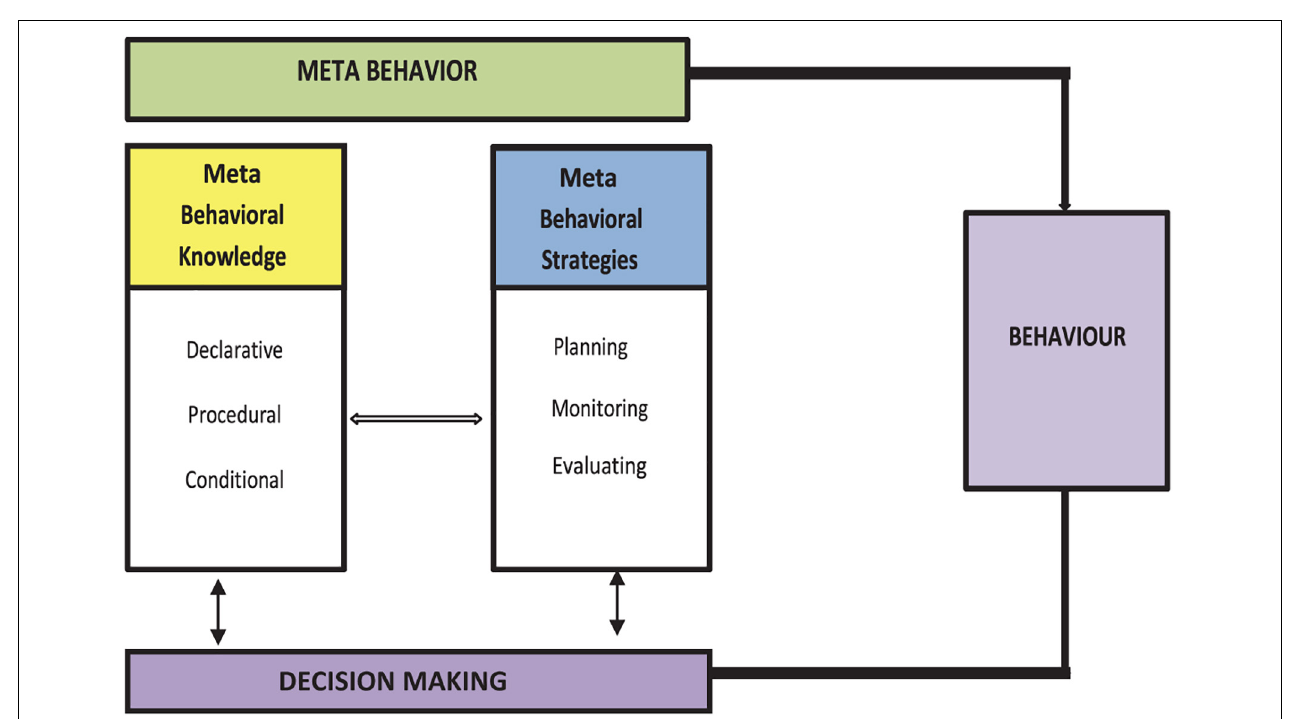
FIGURE 1 | Theoretical perspective that indicates the formation of meta-behavior adapted from Abdullah and Rahman (2018).